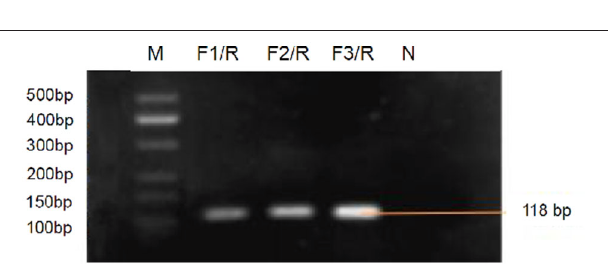
FIGURE 3 | Gel electrophoresis for RPA products amplified by F1/R, F2/R, and F3/R primers, respectively lane M, standard molecular weight. lane N , Negative control (RNase-Free distilled